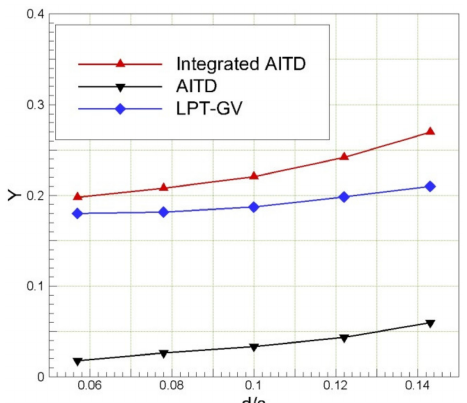
Figure 18. Total pressure loss of the integrated AITD and its components in all